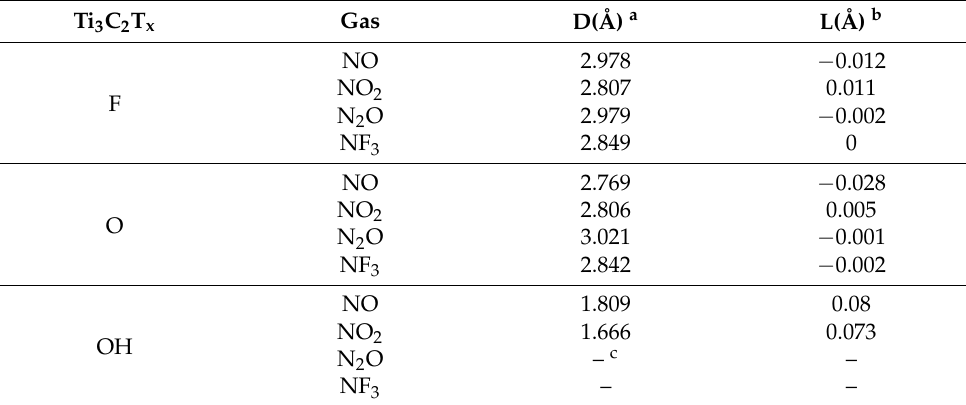
Table 1. Adsorption distance and bond length change of gas molecules on Ti 3 C 2 T x